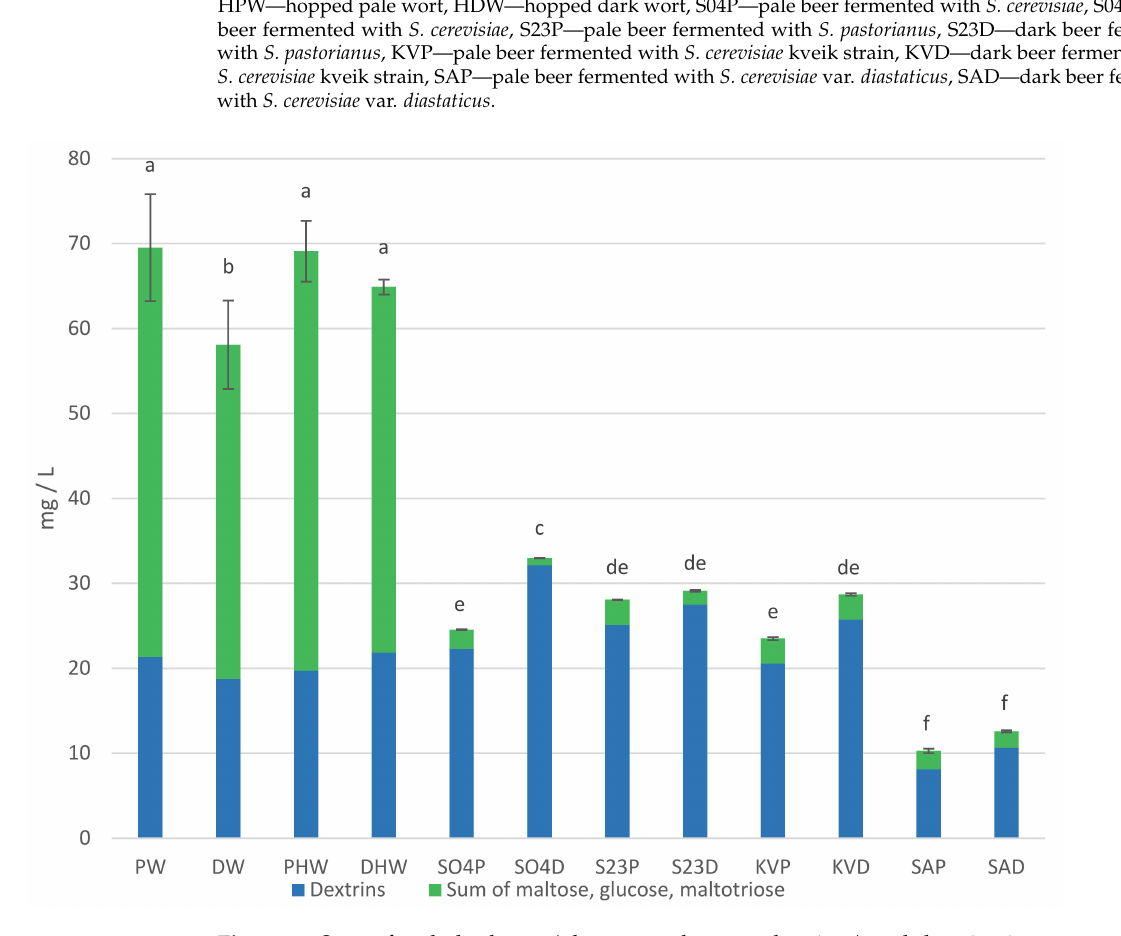
Figure 1. Sum of carbohydrates (glucose, maltose, maltotriose) and dextrins in worts and beers. Values are expressed as mean ± standard deviation. Different letters indicate significant differences between values (n = 2, p <